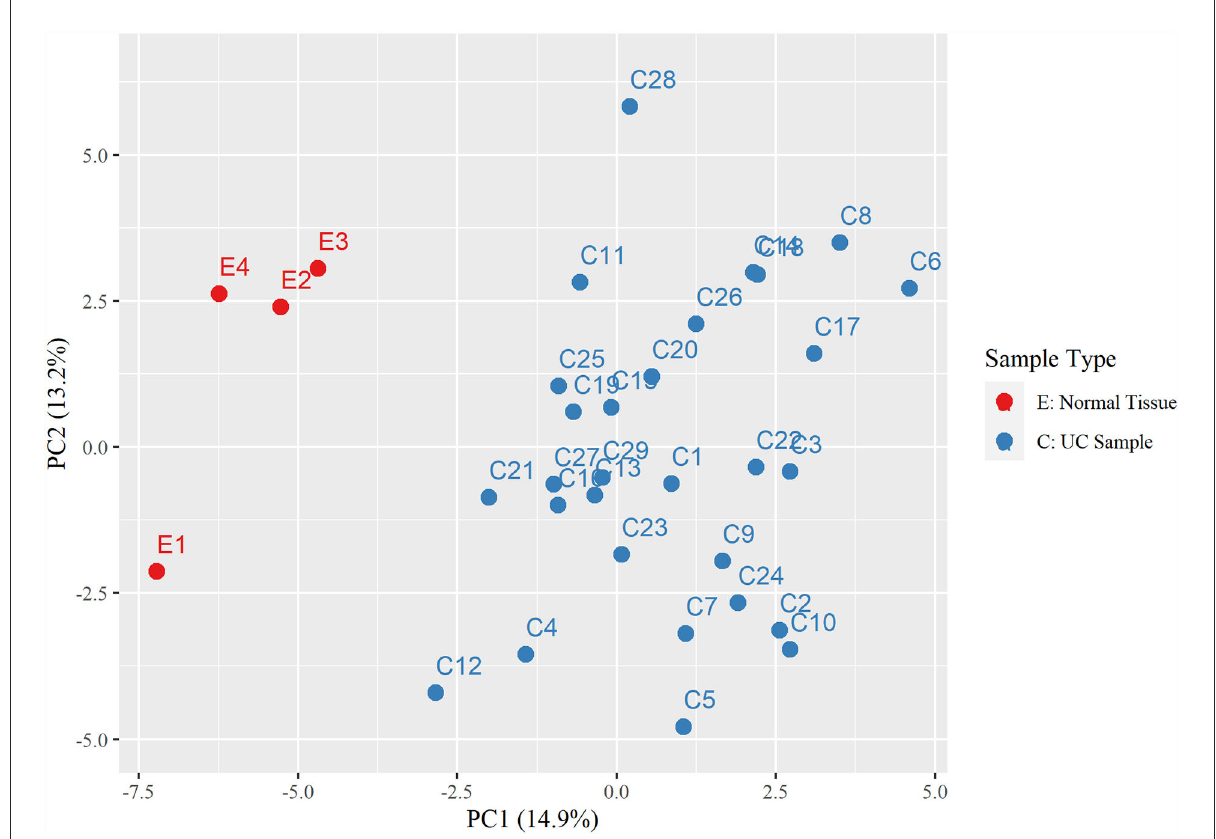
FIGURE3 Principal component analysis displaying a distinct separation between the control urothelial tissues (E1-4) and the invasive urothelial carcinoma samples